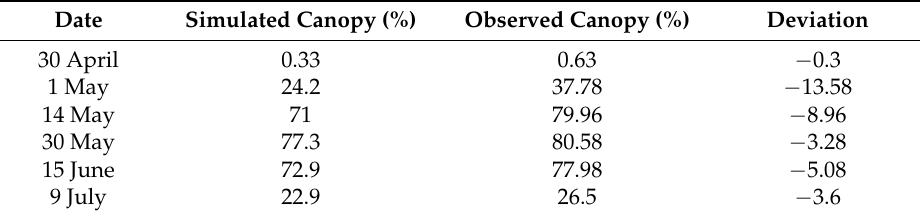
Table 4. Canopy cover development for the September to December 2014 growing